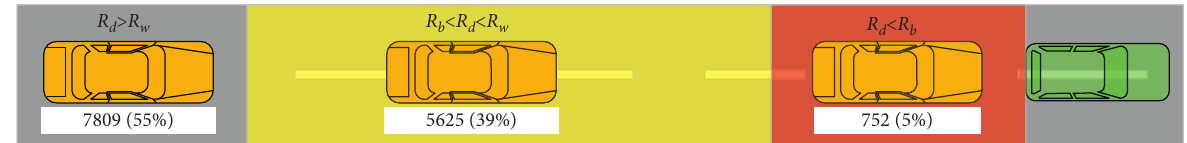
Figure 15: The number of simulations based on SV’s initial position and corresponding crash